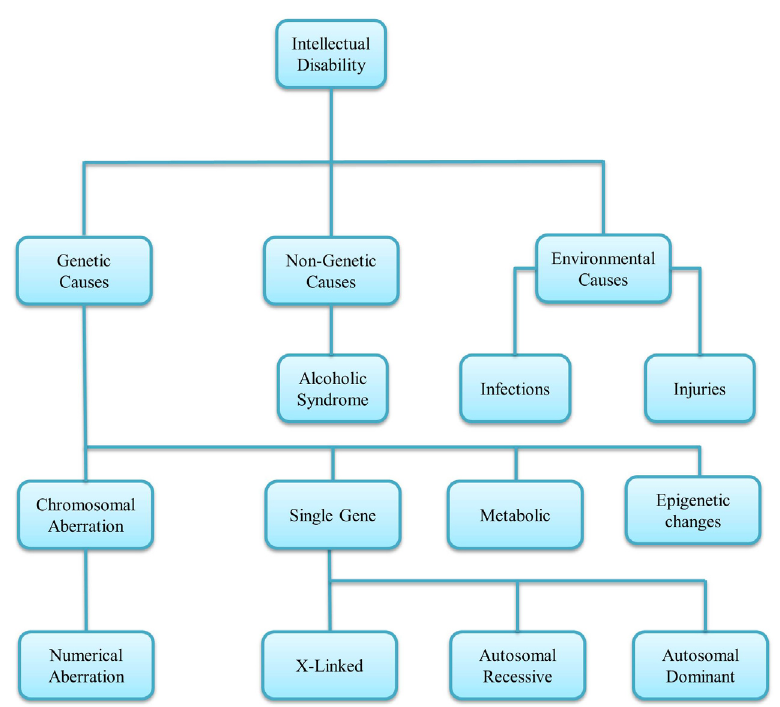
Figure 2. Intellectual disability classification. Multiple factors are involved in intellectual disability including genetic inheritance and environmental